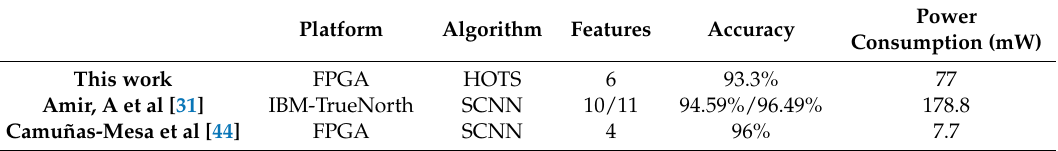
Table 4. Comparison with prior